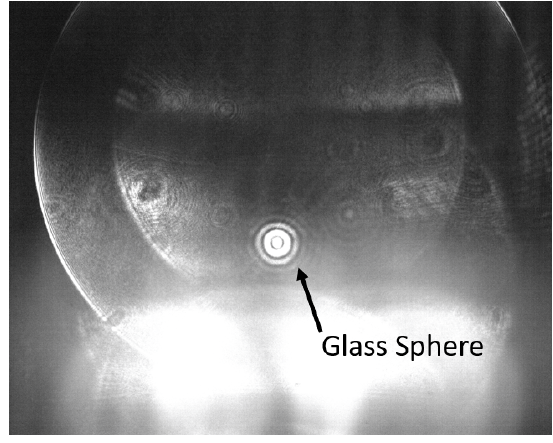
Figure 4. Subsection of a camera image highlighting the noise and blind spots present when viewing the glass sphere captured through the combined SLM camera lens with illumination being provided by laser light projected through the imaging lens.